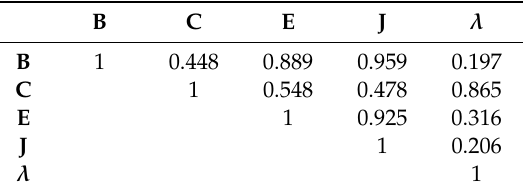
Figure 4. Linear density λ vs. extraction energy.